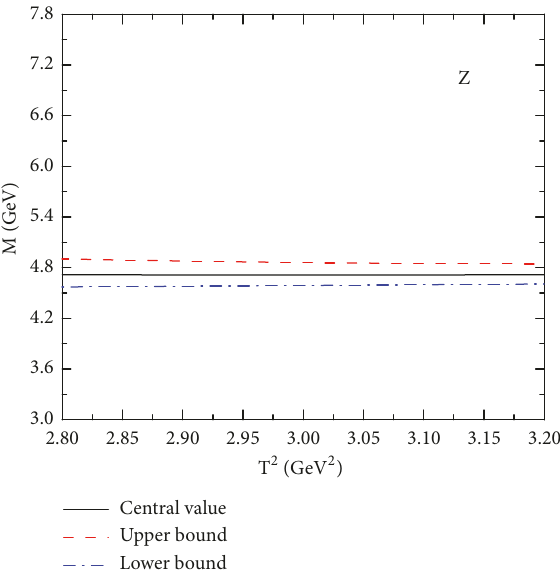
Figure 3: The mass with variation of the Borel parameter 𝑇 2 .